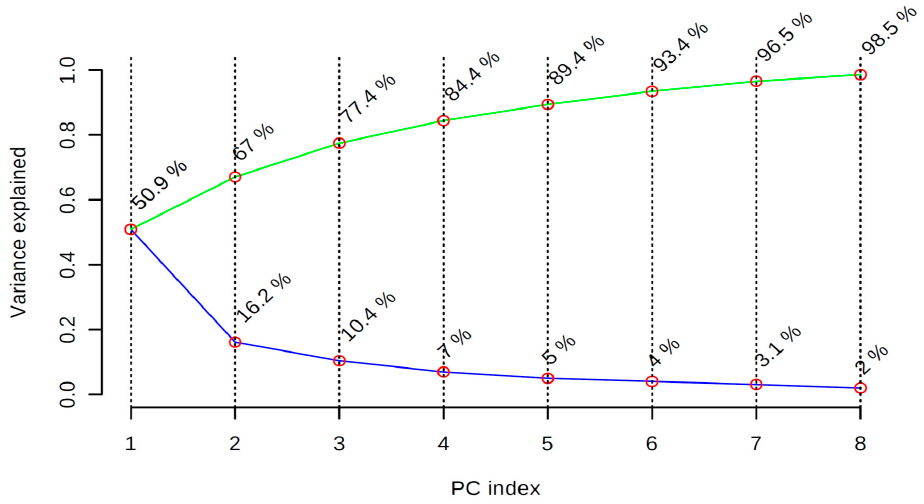
Figure 9. Scree plot showing the variance explained by PC1-PC8 using MetaboloAnalyst 3.0. Green line: accumulated variance. Blue line: variance by individual PC.